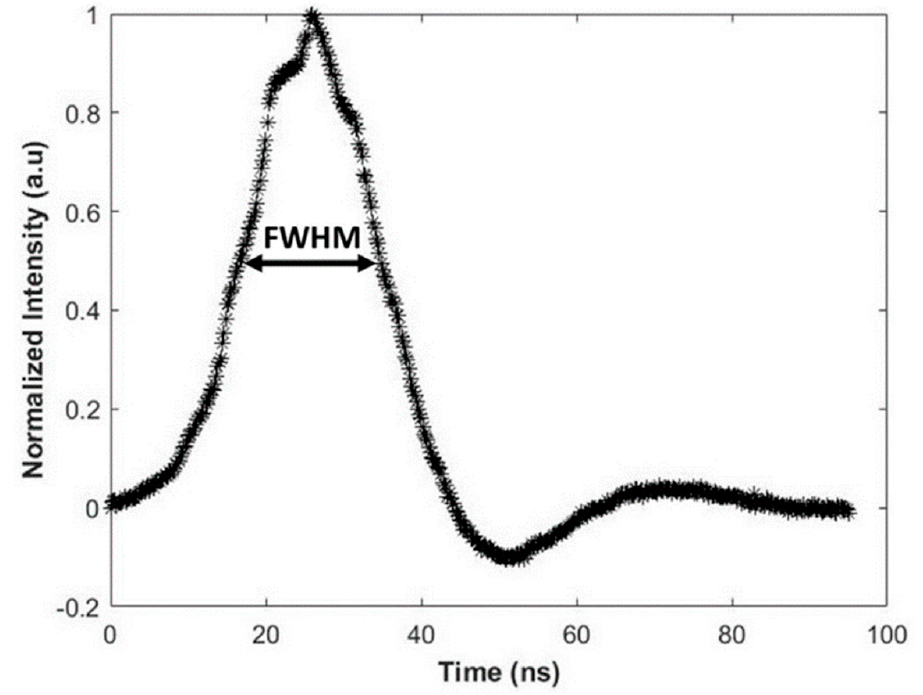
Figure 5. Measured laser pulse temporal profile [37,39], with permission from ASME, 2019.